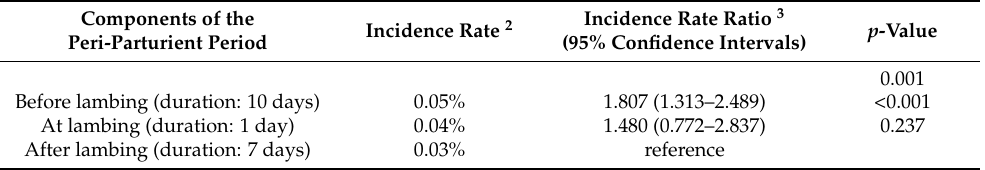
Table 2. Incidence rate of deaths in the three components of the peri-parturient period 1 during a two-year study in 60 sheep flocks in Greece (Poisson regression).